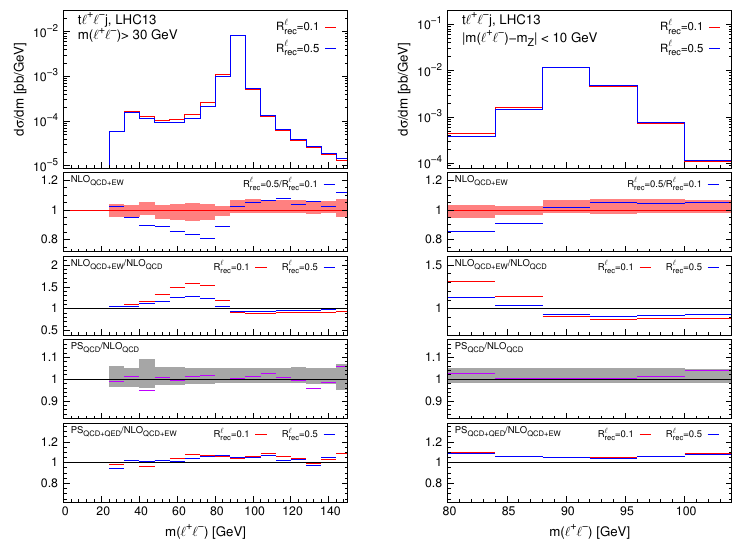
Figure 9 . The m ( ‘ + ‘ (cid:0) ) distribution in t‘ + ‘ (cid:0) j production in the \inclusive" (left) and Z -peak (right) range for di(cid:11)erent recombination parameters. See the main text for details. seen in the (cid:12)rst and second insets. However, this dependence is almost identical in the